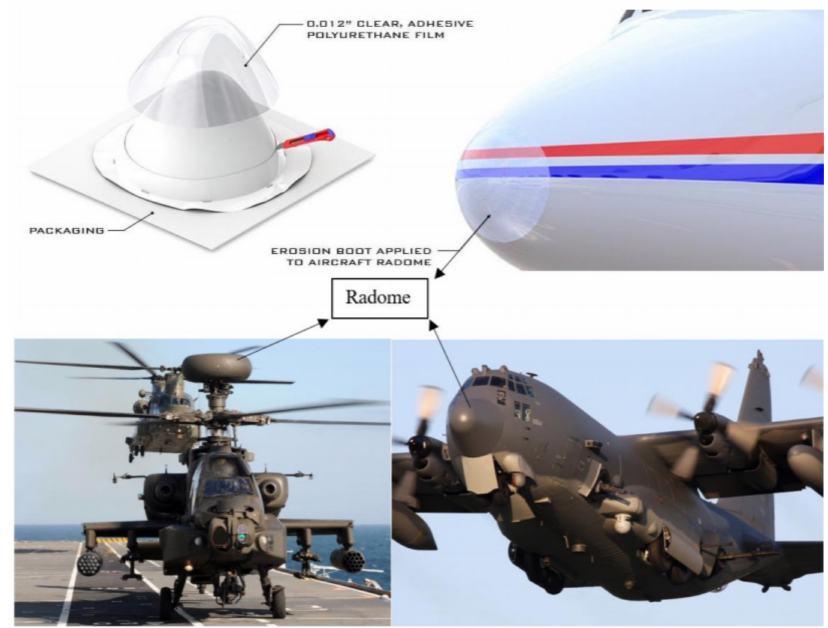
Figure 13. Potential application of hybrid natural fiber composite in aircraft